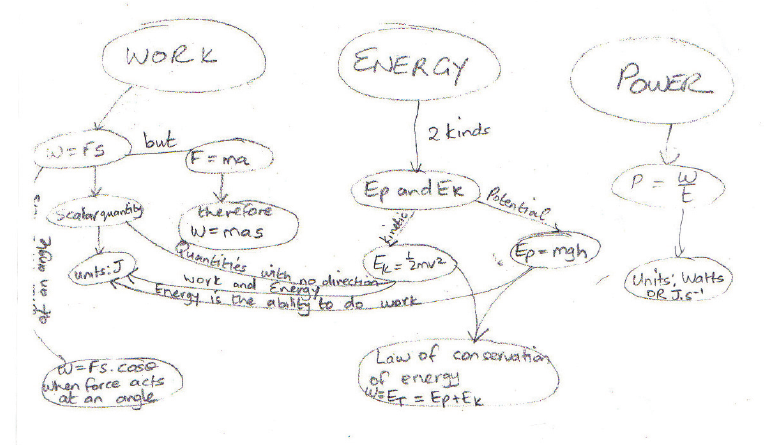
Figure 4 : The Science teacher’s concept map